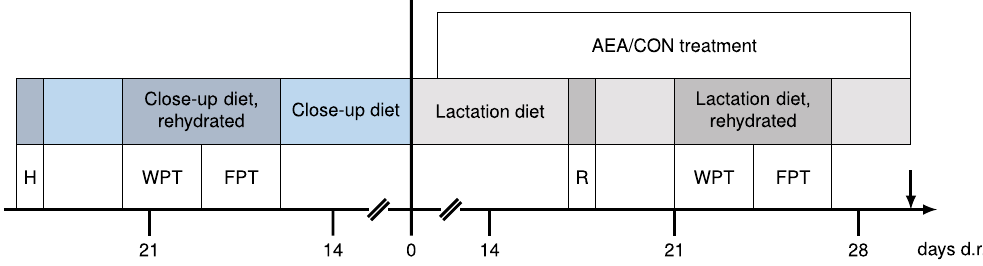
Figure 5. Scheme of the experimental procedure. On day 25 before expected calving, cows were habituated (H) to tie stalls and the experimental setup, this H procedure was repeated on Day 17 p.p as a reminder (R). The